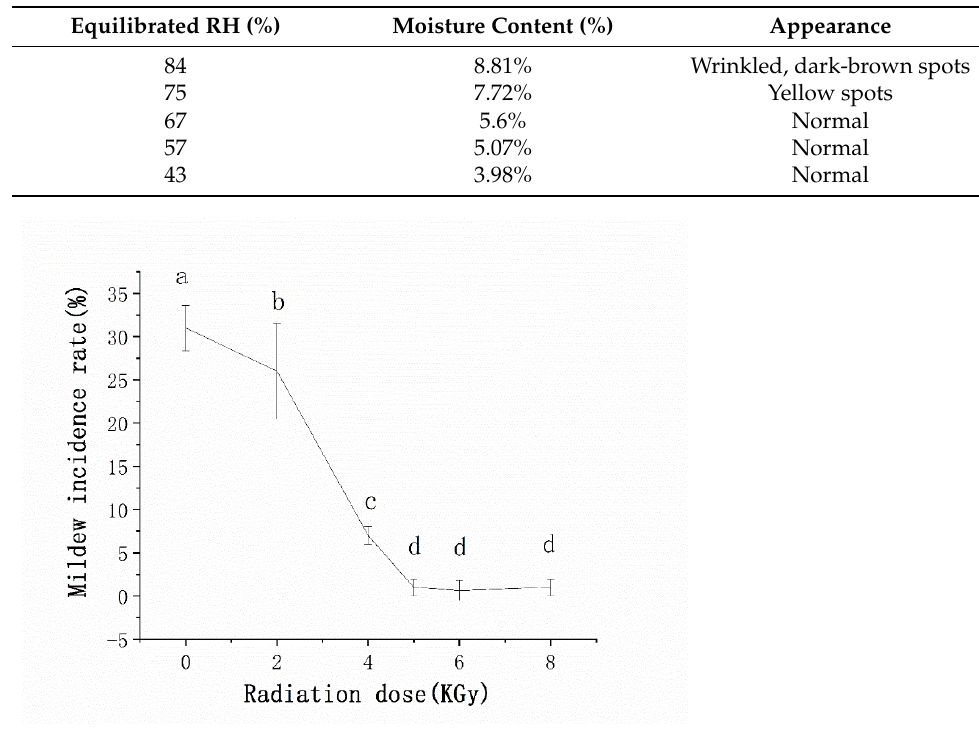
Figure 10. Mildew incidence rate from unmildewed sunflower seeds after various doses of γ radiation. Means with different lowercase letters are significantly different ( p < 0.05). Bars represent the standard deviations.